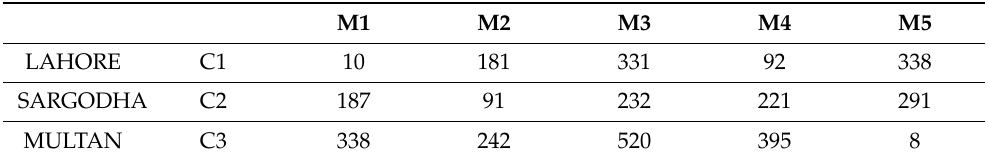
Table A7. Transportation cost of wood pellets between pelletization plants and distribution centers